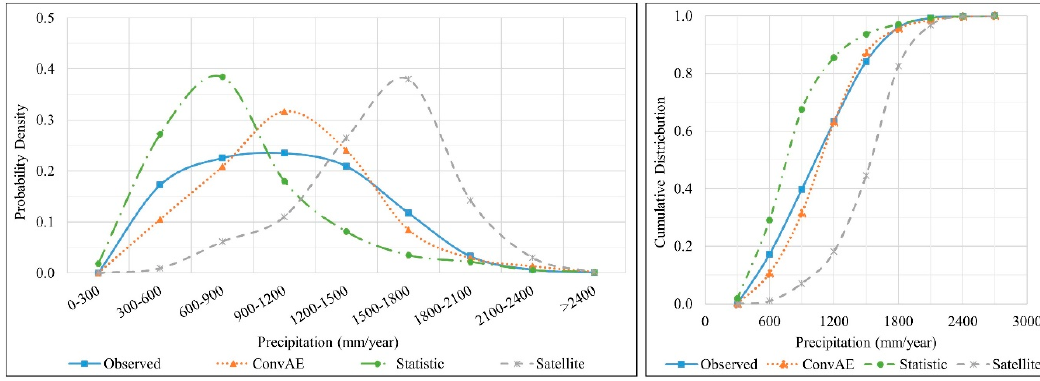
Figure 10. Probability distribution of the total precipitation by grid cells in 2015.